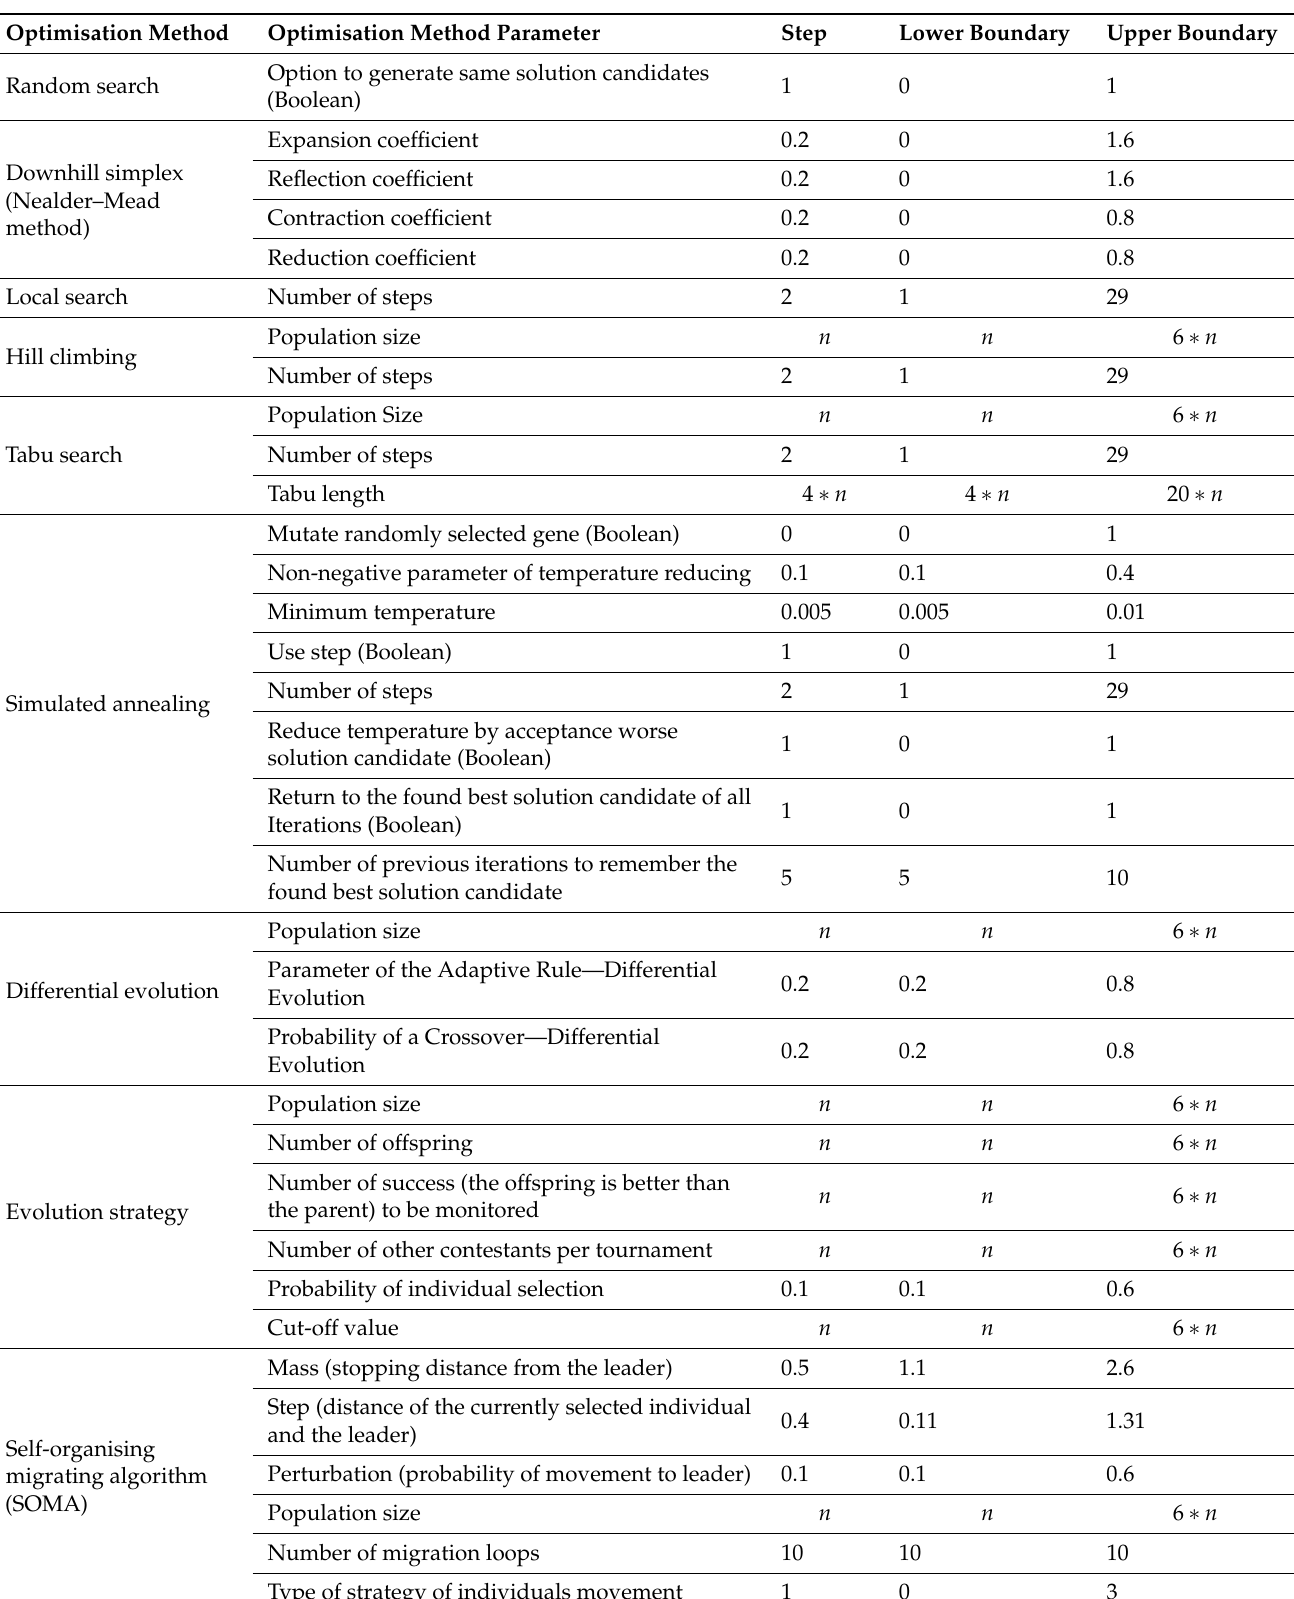
Table 2. Specification of optimisation methods